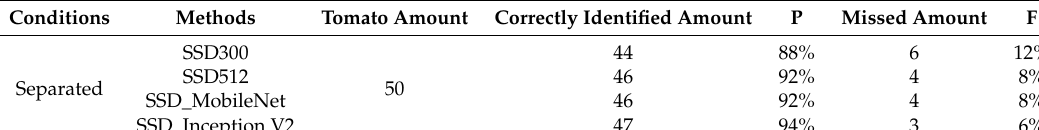
Table 2. The detection results of separated cherry tomatoes.